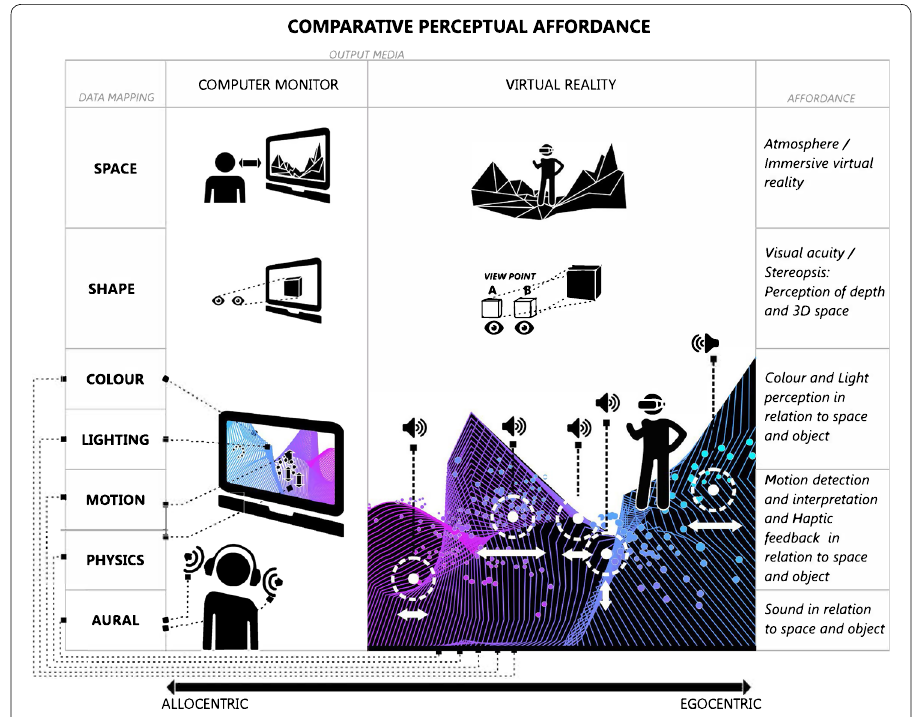
Fig. 3 Comparative affordance of data representation on a monitor and with virtual